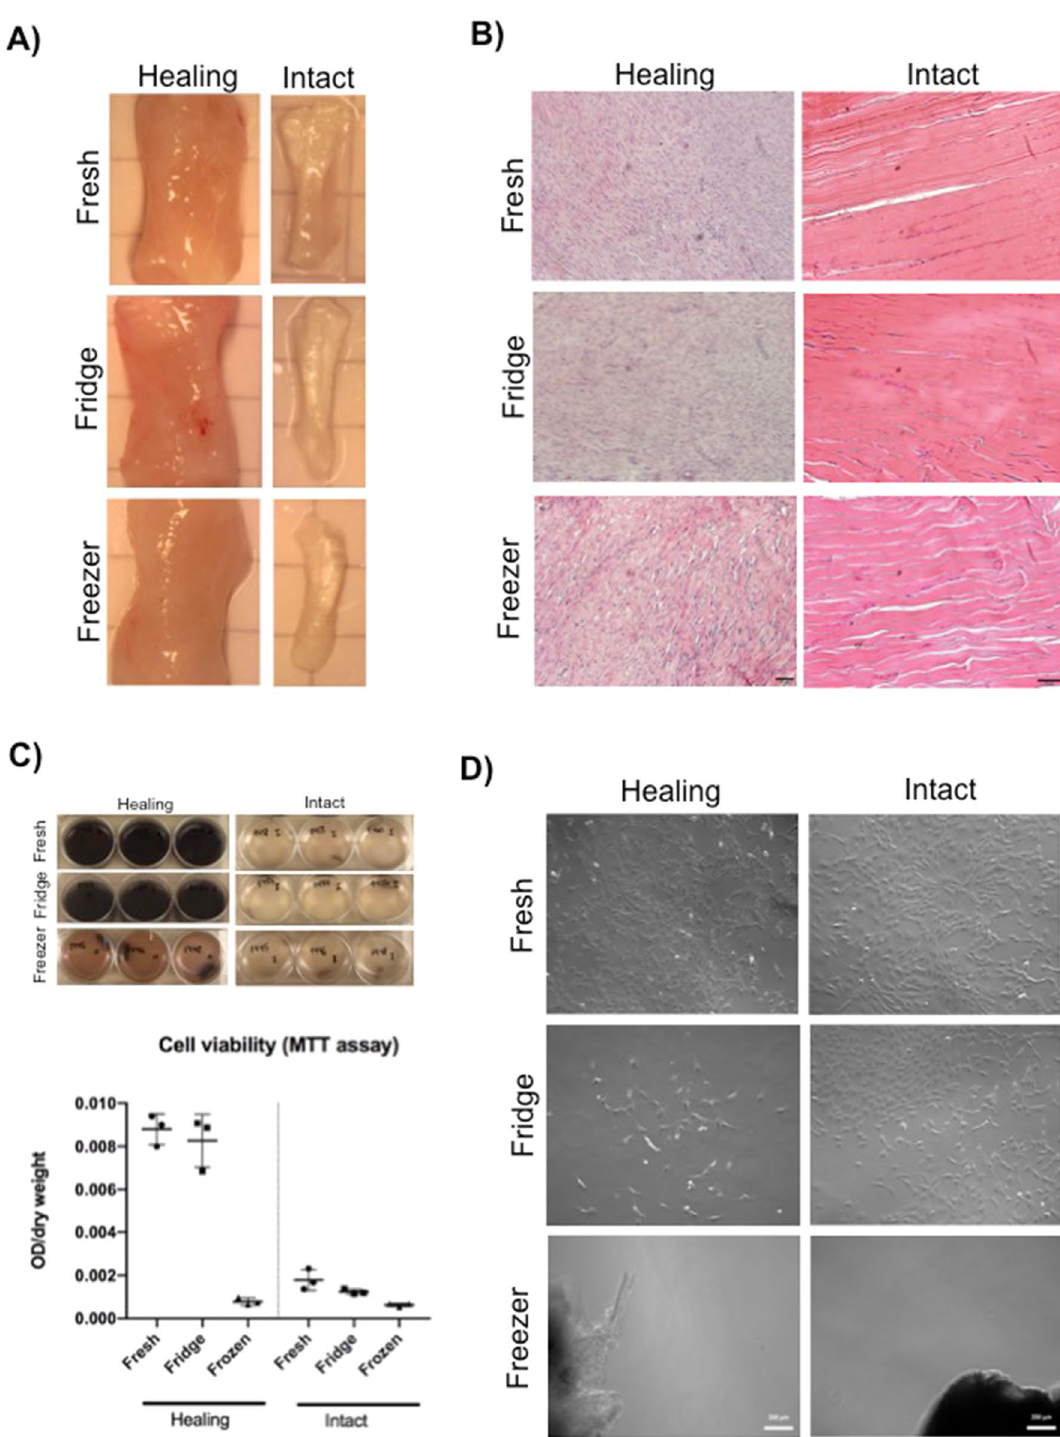
Figure 3. Tissue morphology and cell viability. ( A , B ) Macroscopic and microscopic images from intact and healing tendons after storage. Microscopic images are stained with hematoxylin–eosin. Scale bar for intact tendons 50 µM and healing tendons 20 µM. ( C ) Images of 6-well plates after the dissolvement of formazan crystals in DMSO. Graph represents the MTT assay on intact and healing tendons, verified by absorbance (OD) measurements. The OD is normalized against tissue dry weight. The line represents the mean and the bars SD. ( D ) Explant culture with intact and healing tendons after two weeks. Notice the explants in the frozen samples, where no fibroblast growth was verified. Scale bar 200 µM. Images created by using the software cellsSens Entry (version 1.8.1, Olympus Corporation, www.olymp us-sis.com), Dino Capture 2.0 (version 1.5.3.4,